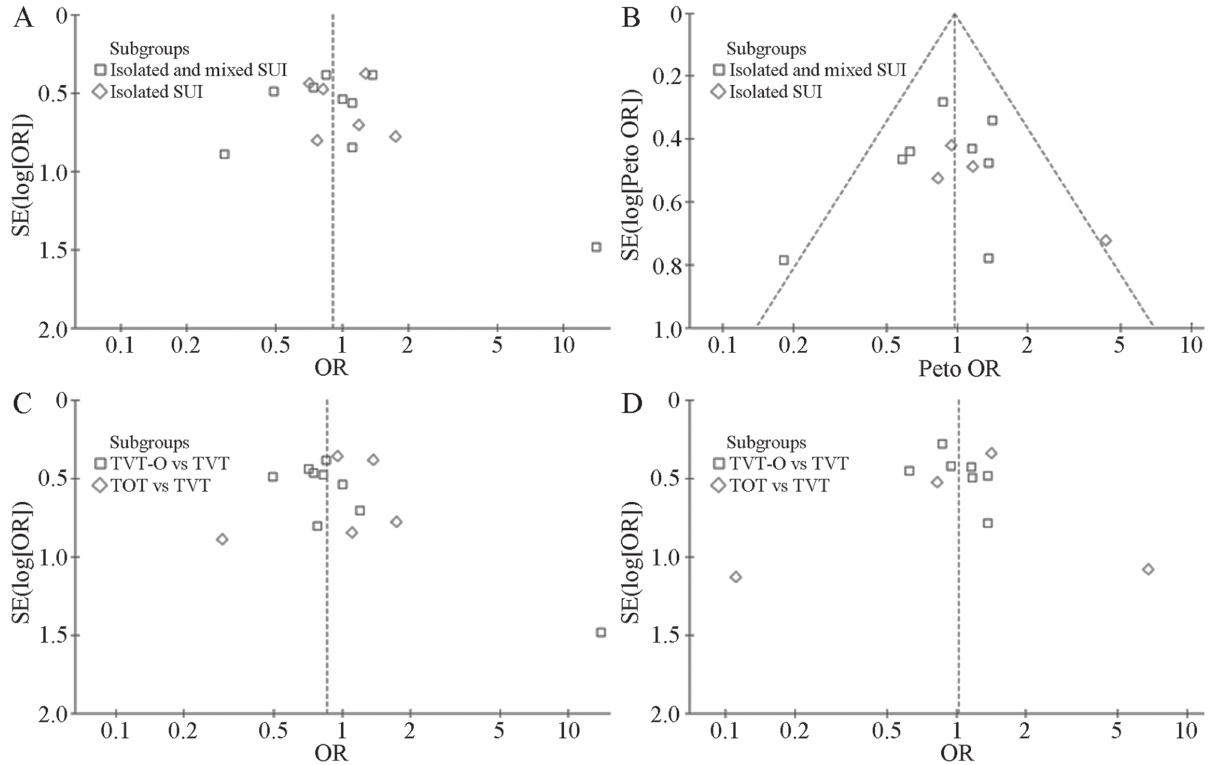
Figure 3 - A and B: Funnel plot of included trials to study the objective/subjective cure of SUI between transobturator and retropubic procedures in the first subgroup analysis C and D: Funnel plot of included trials to study the objective/subjective cure of SUI with procedures by TVT-O/TOT versus